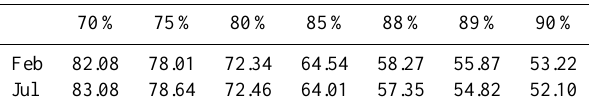
Table 5. Regional- and monthly-average mass concentration thresh- old of PM 2 . 5 (µgm − 3 ) under different relative humidities from the sensitivity test in